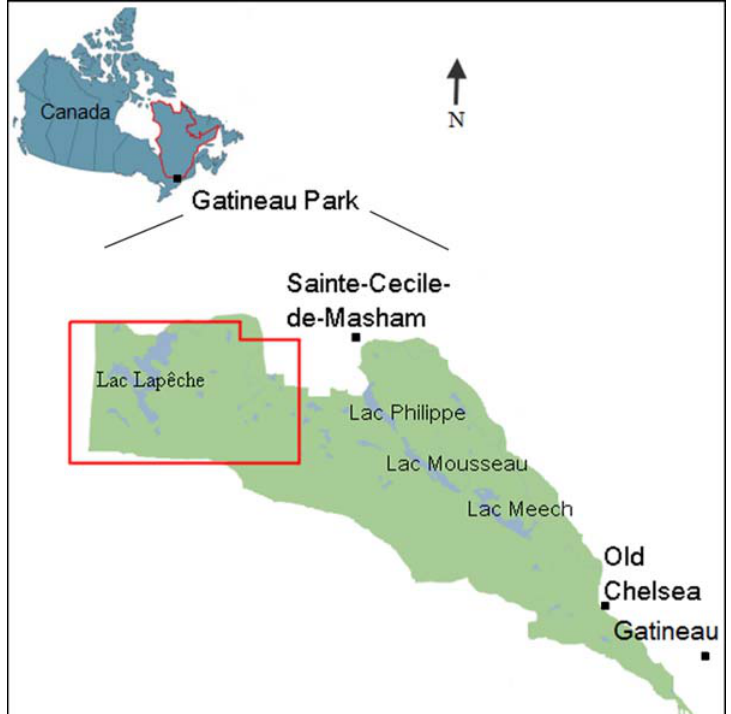
Figure 3. The approximate extents of the 16 × 10 km study area (red outline) shown with respect to Canada, the province of Québec and Gatineau Park (central green area). Adapted from